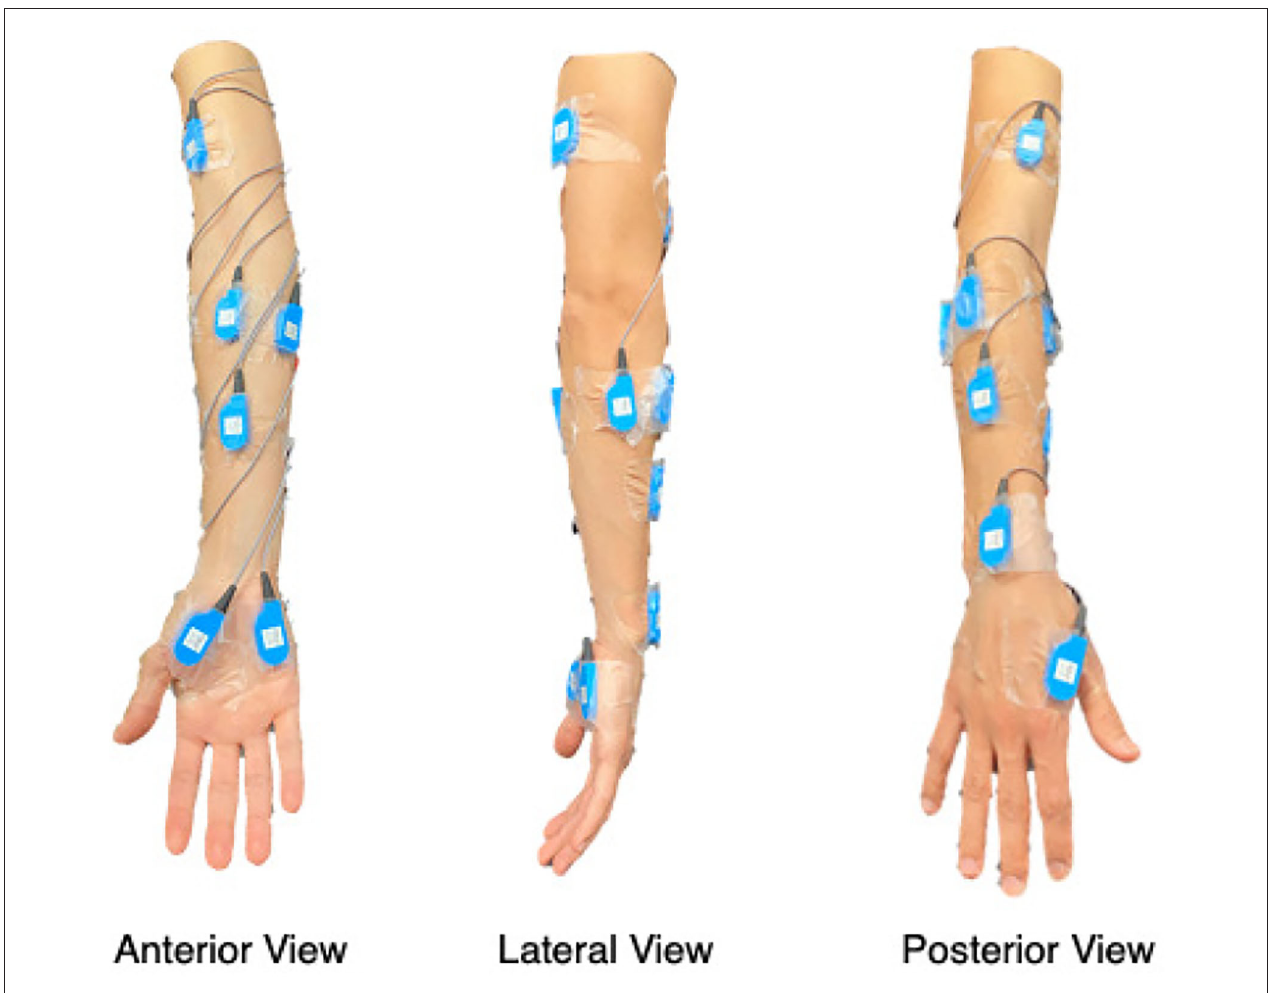
FIGURE 1 | Visualization of muscles targeted during the experiment.